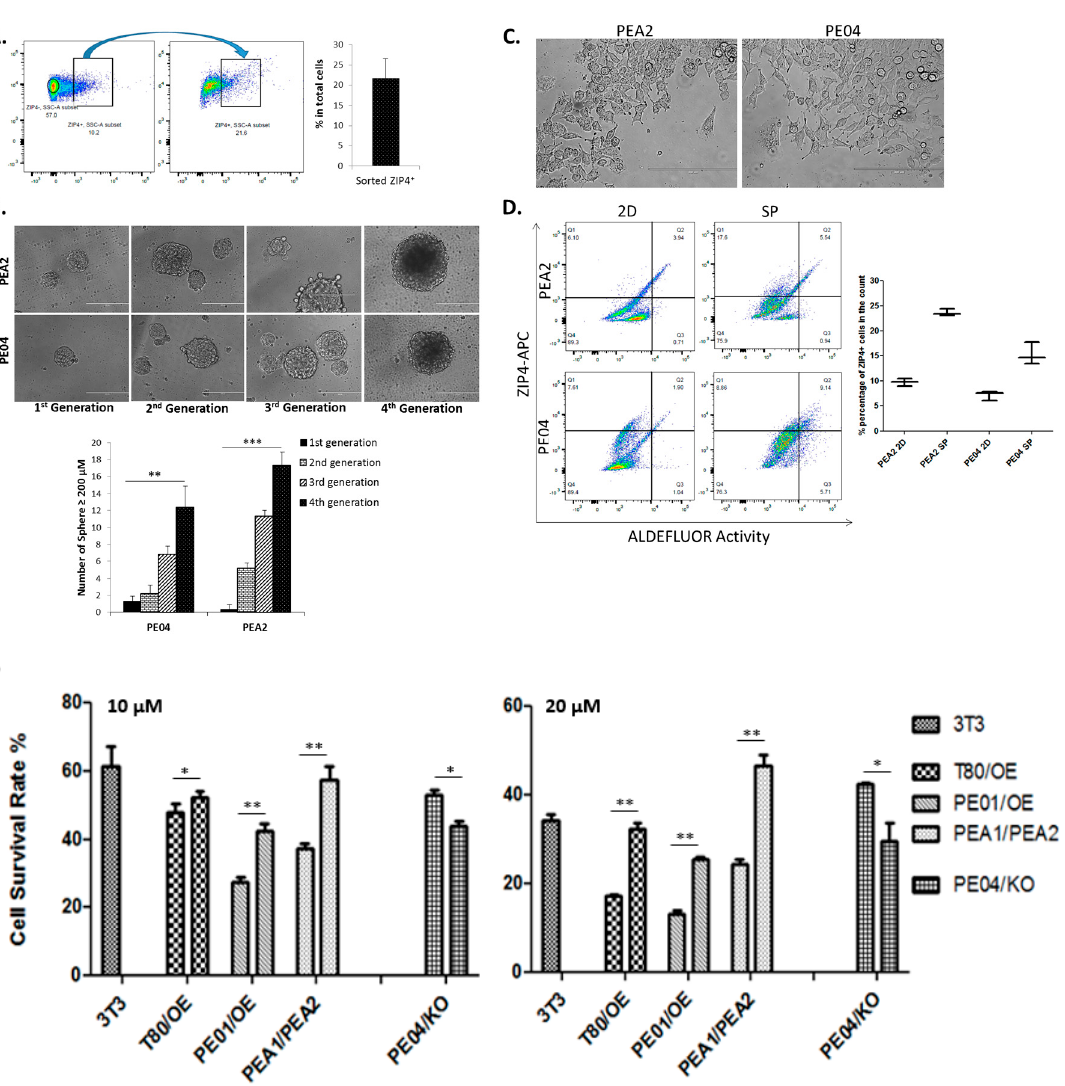
Figure 3. ZIP4 + cells self-renewal capacity and ZIP4 expression correlated with acquired resistance to cisplatin. ( A ) A representative example of flow cytometry and gating for sorted ZIP4 + cells (100% pure) self-renewed to ZIP4 + cells under di ff erentiation conditions. The bar graph on the right depicts the self-renewing capacity of ZIP4 + cells from three independent studies. ( B ) Spheroids formed in each passage. The bar graph on the right depicts the sizes of the spheroids formed in three independent studies (scale bar = 400 µ m). ( C ) The morphology of the di ff erentiated cells from dissociated cells from the fourth generation spheroids (scale bar = 400 µ m). ( D ) FACS analyses of ZIP4 + and ALDH + cells in 2D di ff erentiated cells vs. the spheroids (four time passaged) in PEA2 and PE04 cell lines. ( E ) The sensitivity to cisplatin of PE01 / ZIP4-OE, PE04 / ZIP4-KO, T80 / ZIP4-OE, and PEA1 / PEA2 cells was detected by the MTT assay. * p < 0.05, ** p < 0.01, *** p <